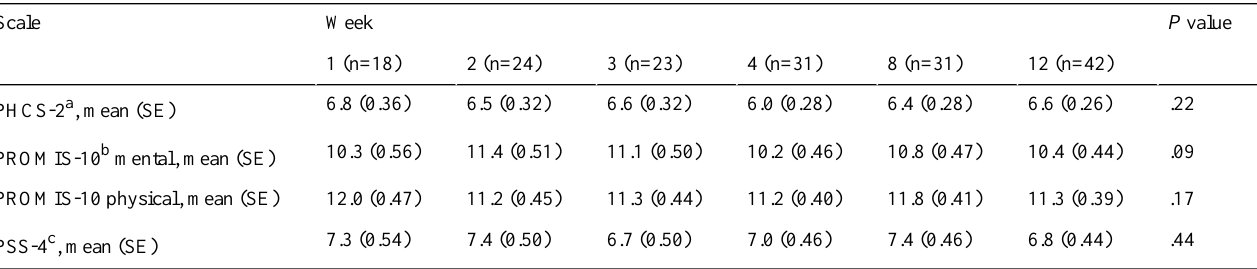
Table 2. Least squares means of computed scores for each scale per